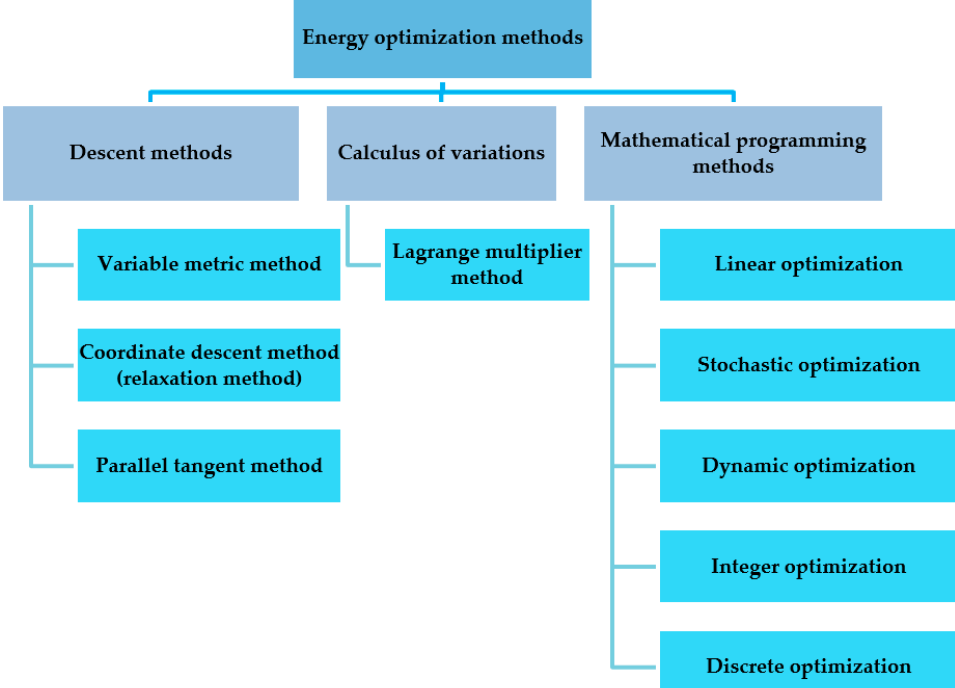
Figure 2. Energy optimization methods.